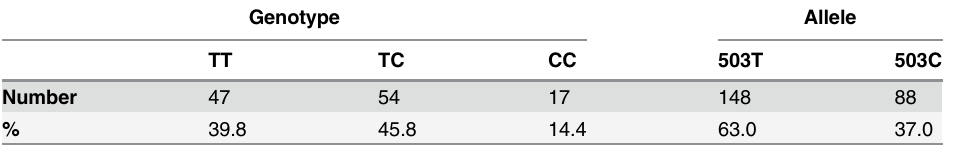
Table 1. Frequency of the CD161 c.503T > C polymorphism in healthy individuals a